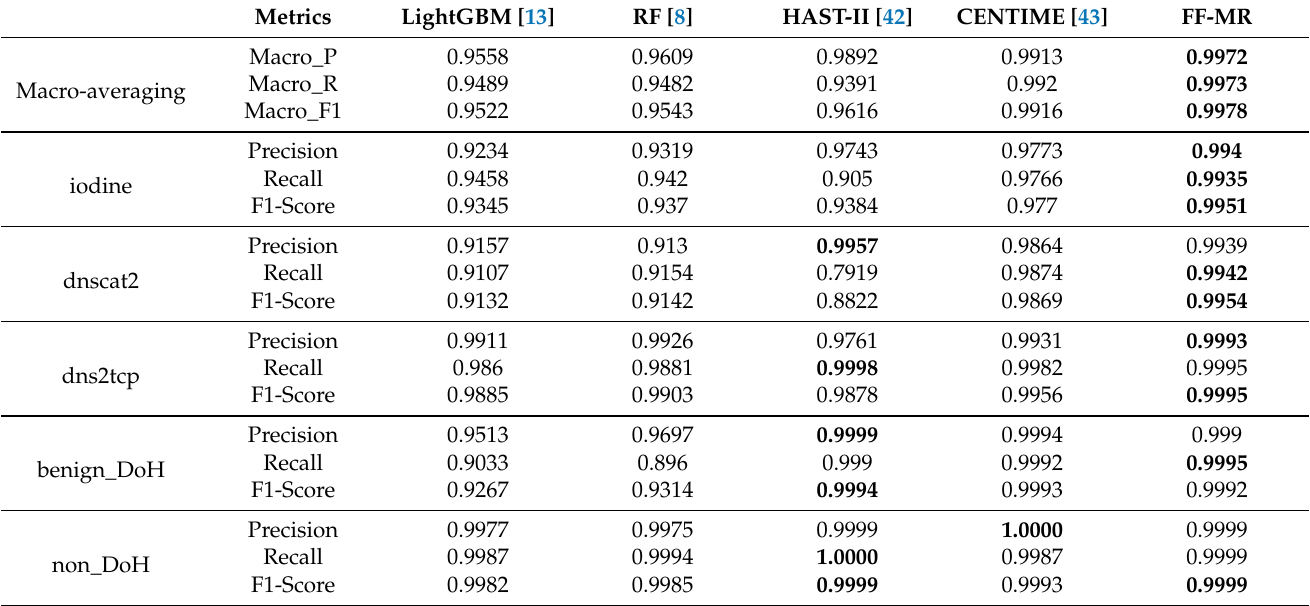
Table 5. FF-MR vs. other